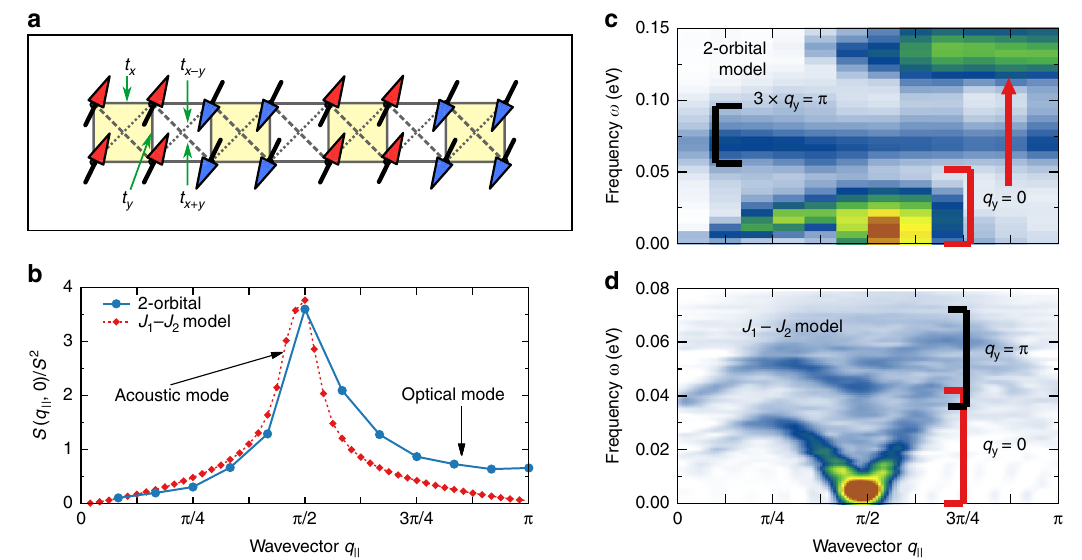
Fig. 7 Spin dynamics within the ladder geometry. a Schematic representation of the two-orbital two-leg ladder system used in our analysis (see Methods section for details). Arrows depict the 2 × 2 block state. b Static SSF in the q y = 0 sector for both bthe J 1 – J 2 and multi-orbital models on a ladder geometry. c , d Dynamical SSF of the c two-orbital and d J 1 – J 2 spin models on a two-leg ladder geometry (using L = 12 and L = 48 rungs,